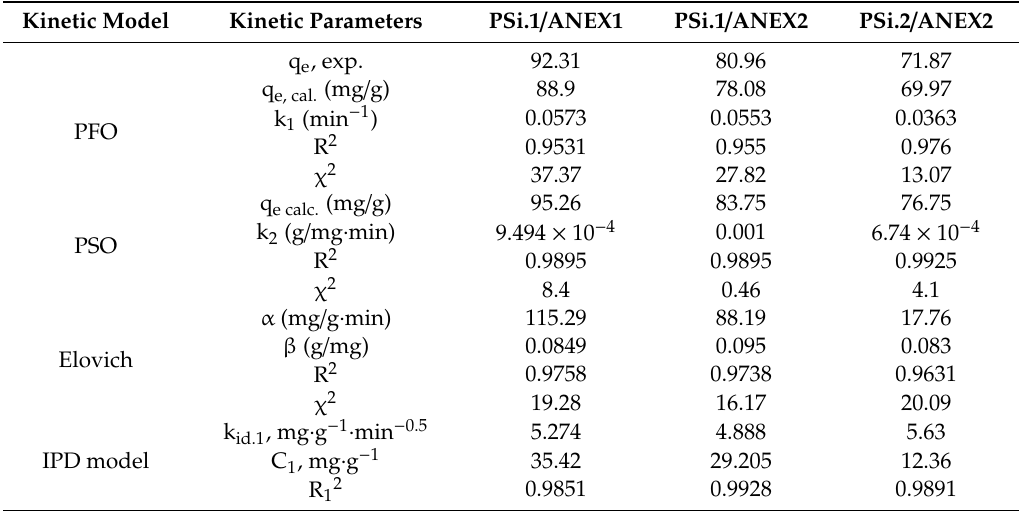
Table 1. Kinetic parameters (m sorbent = 10 mg, V sol = 10 mL, C in = 100 mg/L, temp. 23 °C, pH 4). Kinetic Model